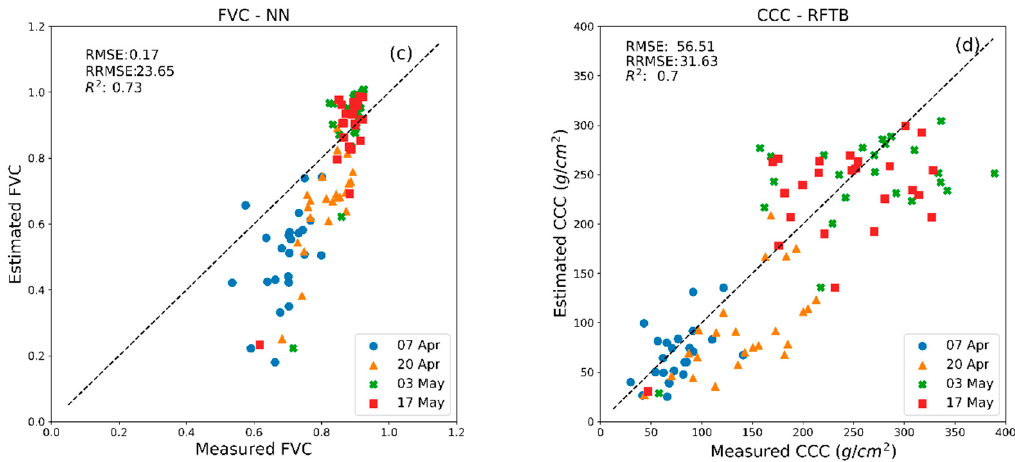
Figure 4. Best performing algorithms for ( a ) LAI, ( b ) LCC, ( c ) FVC, and ( d ) CCC retrieval for the dataset from Shunyi, China. The horizontal error bars for LCC represent the standard deviation of single chlorophyll measurements.